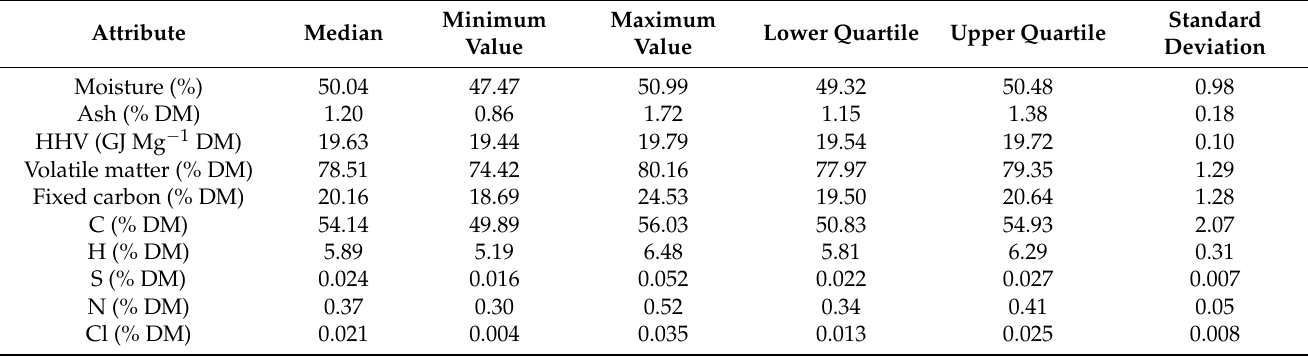
Table 8. Selected statistical analysis indicators for the willow characteristics under